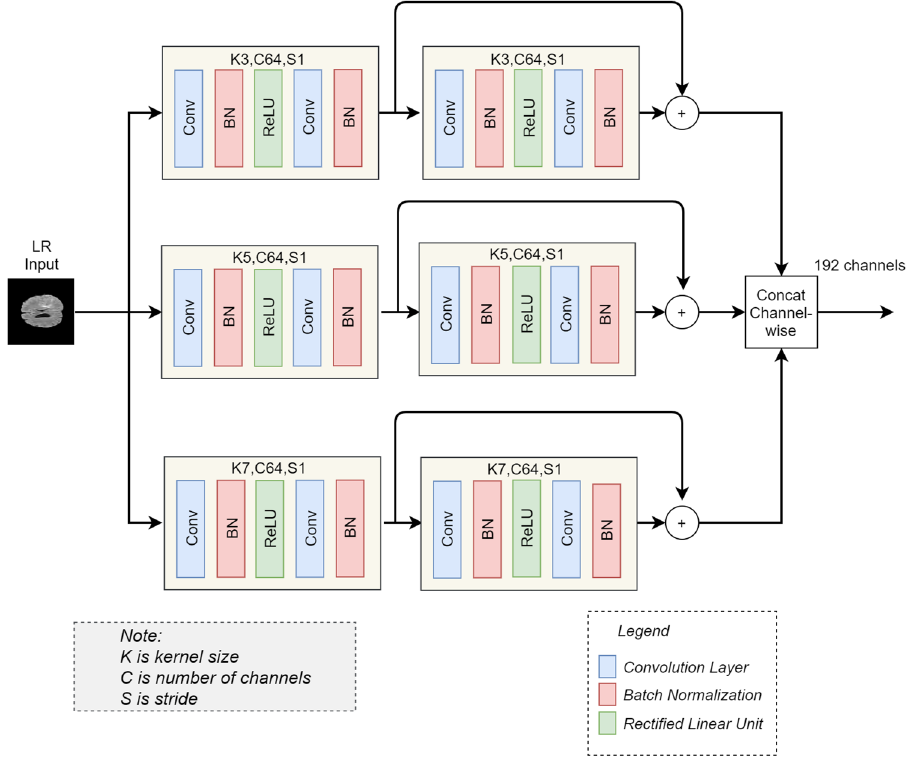
Figure 2. Multi-path upscaling. The figure demonstrates the shallow feature extraction on three different scales. The features are then concatenated channel-wise. K, C and S denotes kernel size, number of channel and stride, respectively.